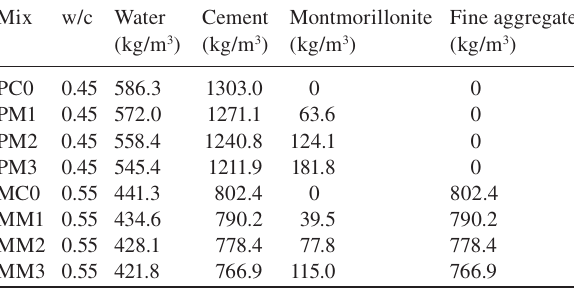
Table 3 Mix proportions of cement paste and cement